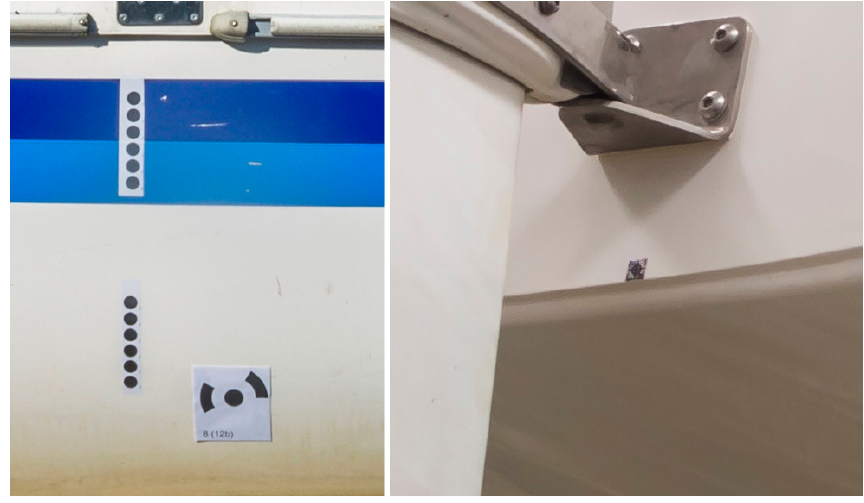
Figure 4. Types of the used targets.